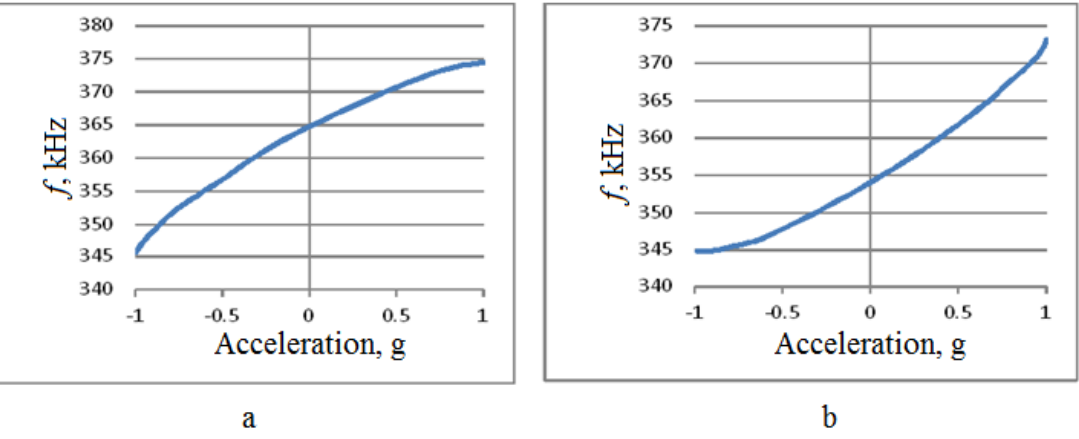
Figure 14. The output characteristic for rotations around the x -axis. ( а ) — rotation from − 180° to 0°, ( b ) — rotation from 0° to +180°.